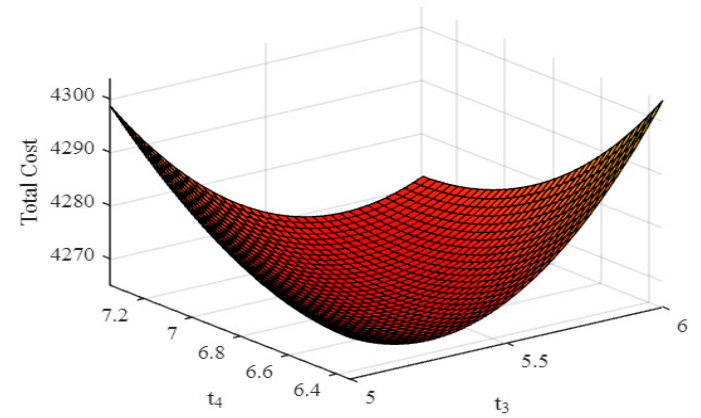
Figure 2. Total cost function of the inventory system.